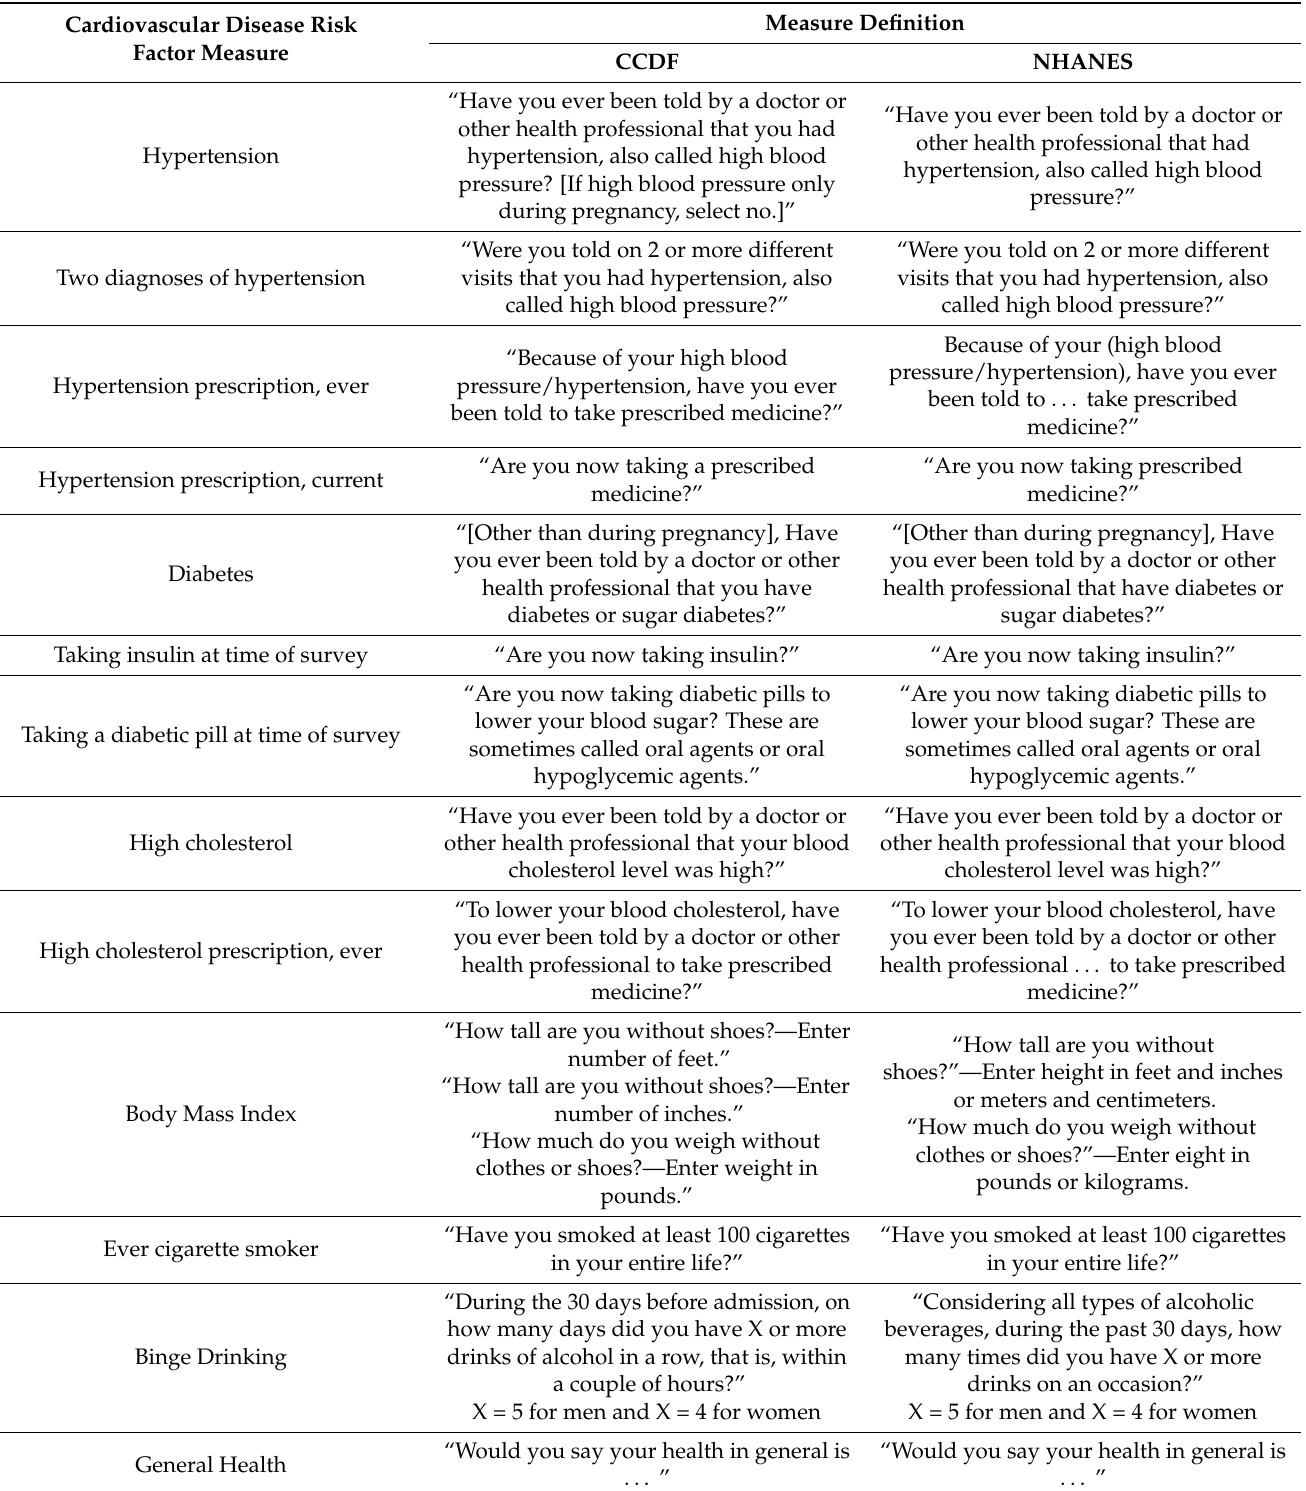
Table 1. Cardiovascular disease risk factor measurements among Coconino County Detention Facility (CCDF) participants and matched National Health and Nutrition Examination Survey (NHANES) participants,